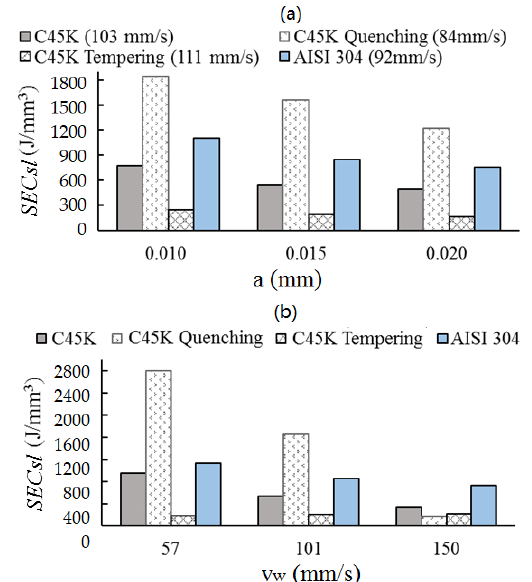
Figure 5. Relationship between specific energy consumption and ( a ) depth of cut, and ( b ) workpiece